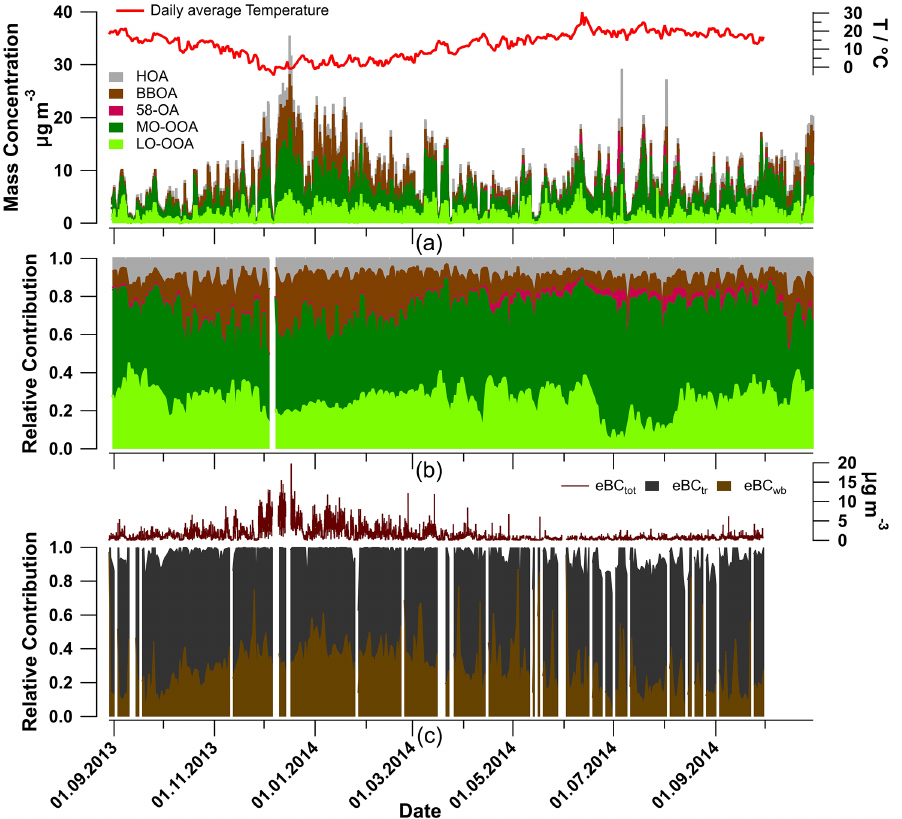
Figure 3. Annual cycles of OA components: (a) absolute and (b) relative OA contributions plotted as 30min resolved time series, and (c) black carbon source apportionment.